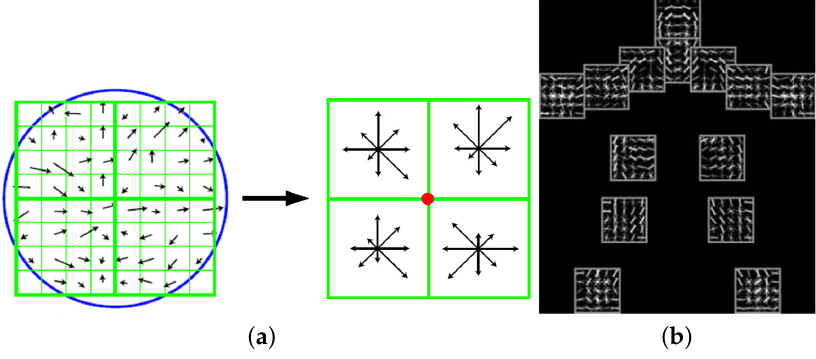
Figure 6. Two widely utilized feature extractors and descriptors. ( a ) Scale Invariant Feature Transform (SIFT); ( b ) Histogram of Gradient (HOG) templates